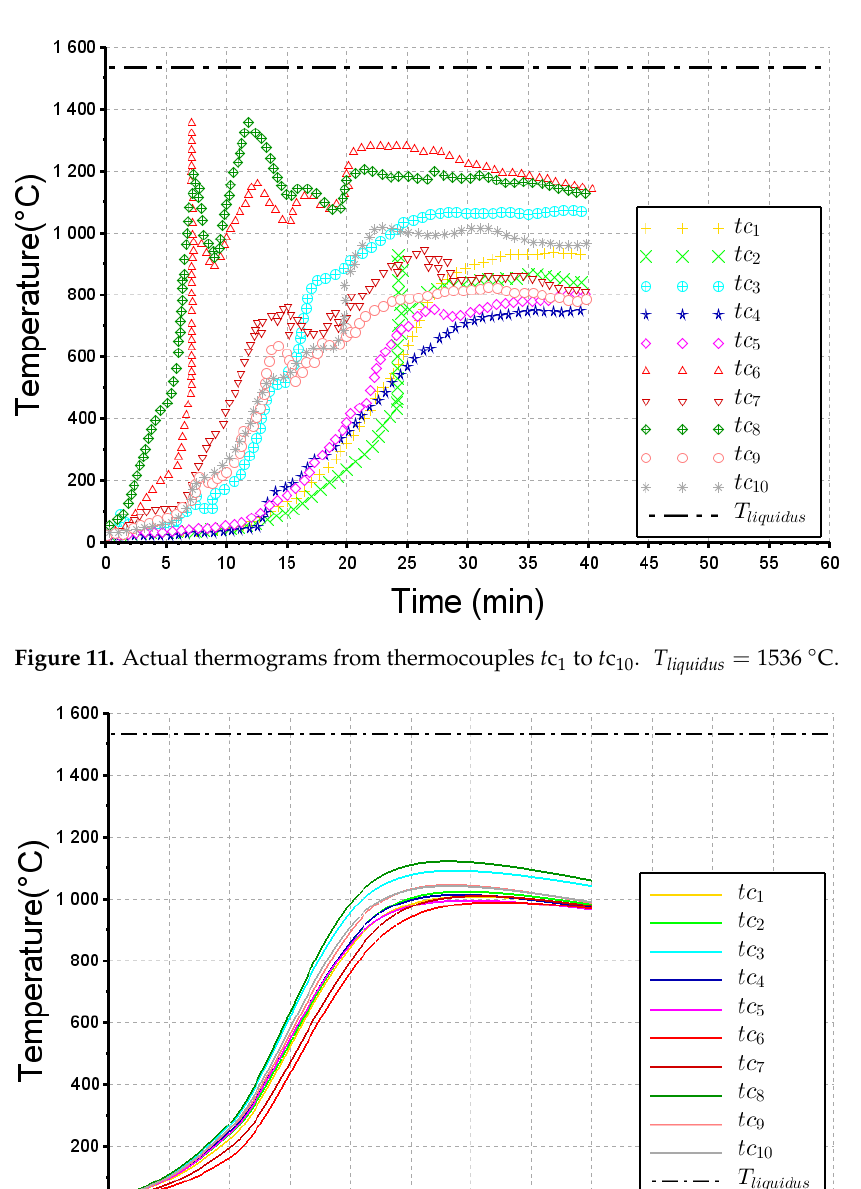
Figure 12. Computed temperature at the location of thermocouples 𝑡𝑐 1 to 𝑡𝑐 10 . 𝑇 𝑙𝑖𝑞𝑢𝑖𝑑𝑢𝑠 = 1536 °C